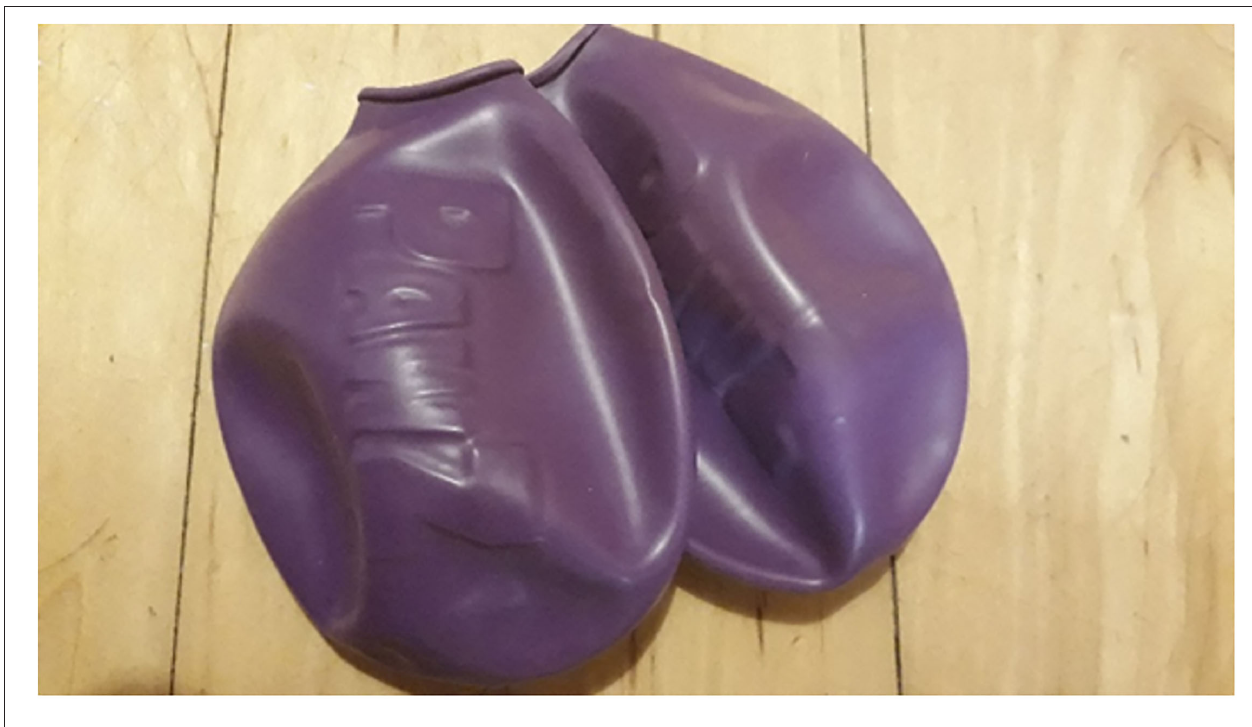
FIGURE 1 | The tested dog boots in size “large” (see text footnote 1).